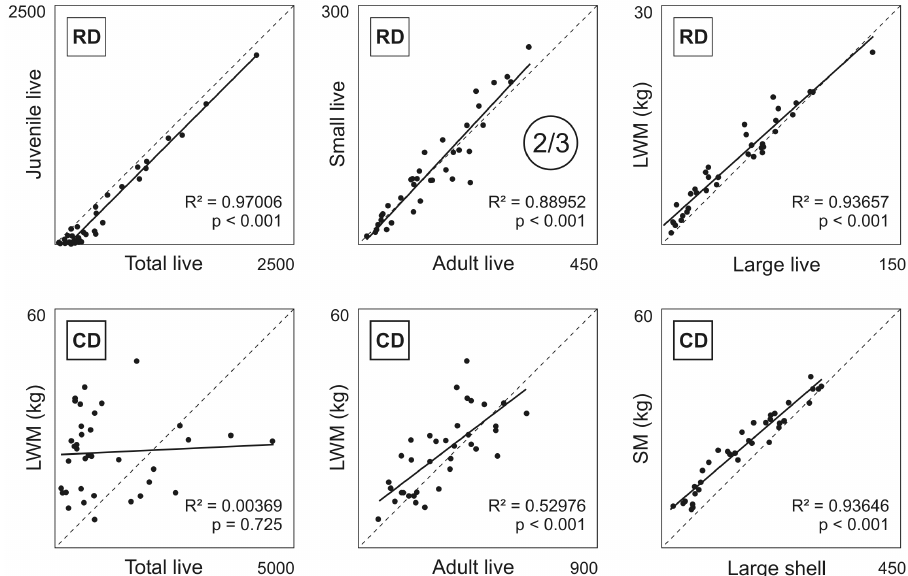
Figure 11. Interrelations between selected oyster density attributes per site and year (N = 36 reefs). Given are linear relationship, coefficient of determination (R²) and significance level (p). Proportional reference line (dotted) and proportions indicated (circles). See text for all other interrelations. Density metrics and density attributes according to Figure